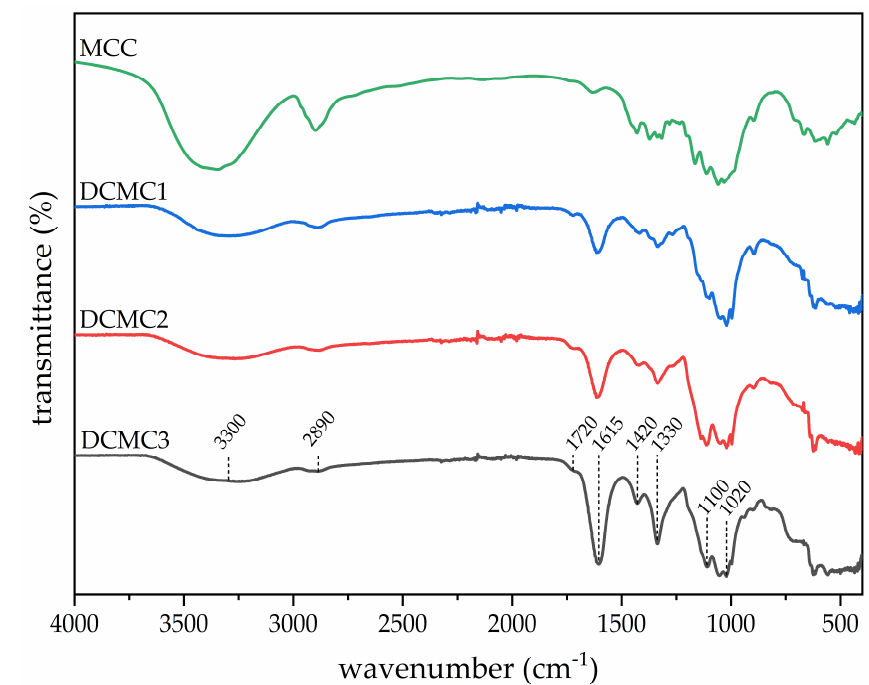
Figure 4. Attenuated total reflection Fourier-transform infrared spectroscopy (FTIR-ATR) spectra of microcrystalline cellulose (MCC) and dicarboxymethyl cellulose polymers (DCMC 1, DCMC 2, and DCMC